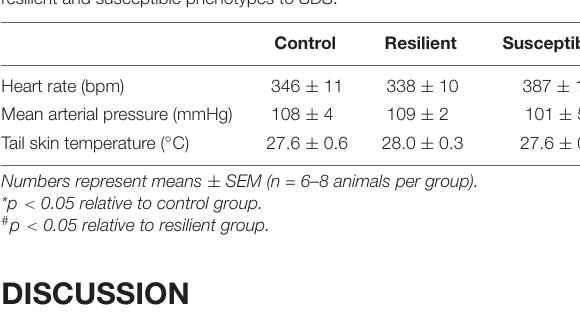
Frontiers in Physiology |